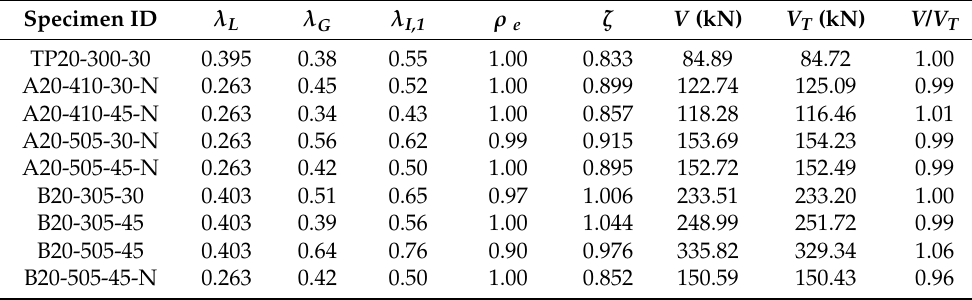
Table A17. Analysis results of test specimens reported by Moussa [29].